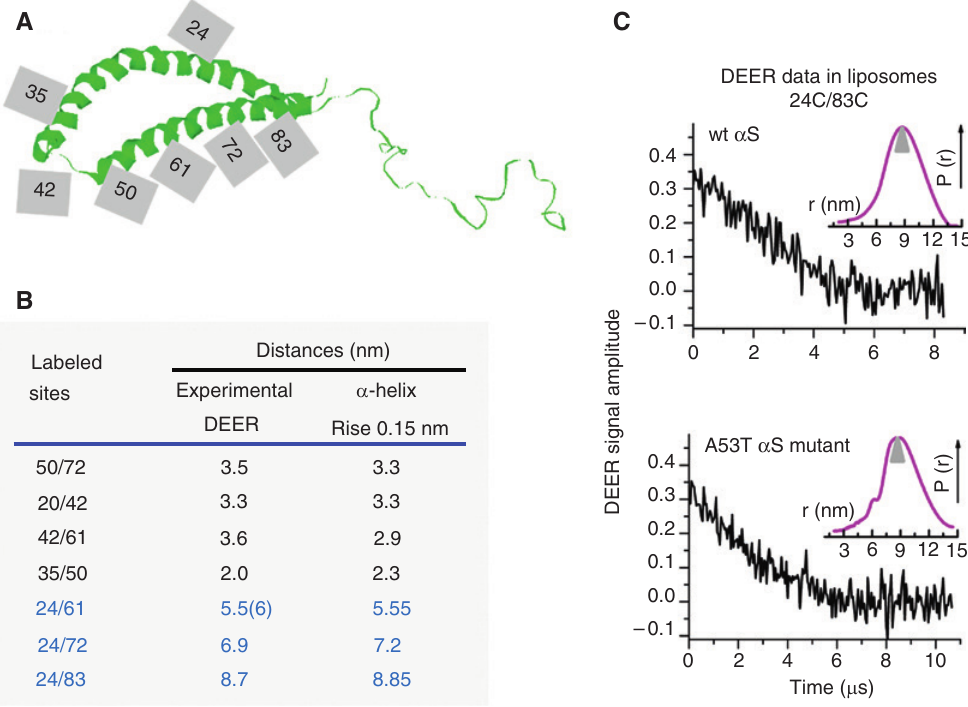
Figure 8: DEER-derived distances suggest single-extended helix conformation of lipid-bound α S (Ref. 68 and 69). (A) Cartoon of micelle- bound α S determined by NMR (PDB 1XQ8). Shown are the approximate positions of spin-labeled α S residues used for DEER distance measurement in wt protein and familial Parkinson’s disease (PD) mutants (A30P, E46K, A53T). (B) The DEER-derived distances for liposome- bound multiple double spin-labeled mutants in wt α S agree well with those expected for an extended alpha helix, but not the U-shaped conformation. The distances between the residues within the same segment of the broken helix are shown in black while those between different segments are in blue. Similar distances were measured in context of bicelles, and for all α S variants (wt and PD mutants). (C) The background-corrected DEER time-domain data (black) and reconstructed distances (magenta) for spin-labeled-residues 24C/83C in wt α S and A53T mutant. Very long distances of up to ca. 9 nm were